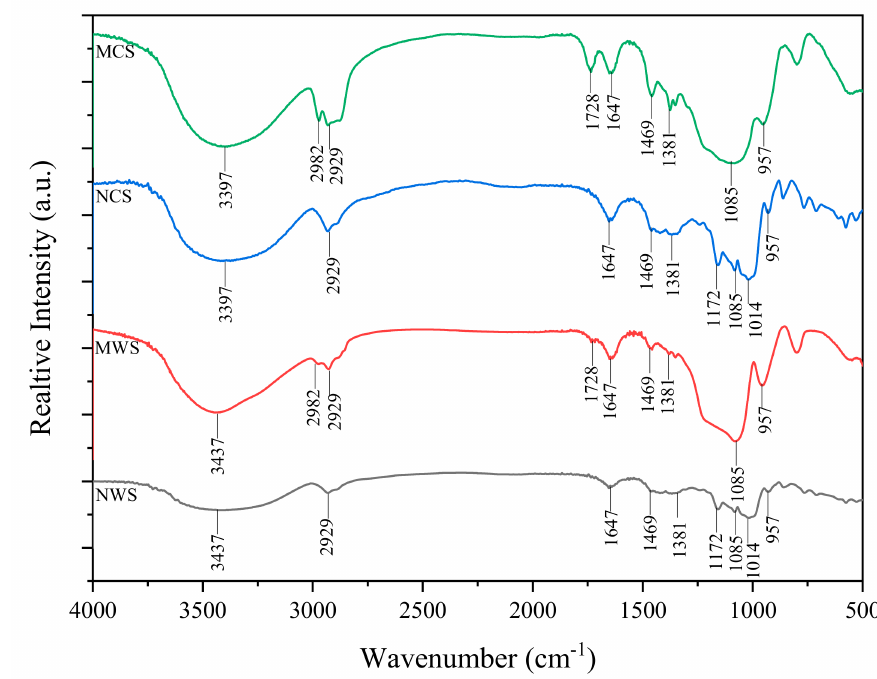
Figure 2. FTIR spectra of the native (NWS and NCS) and modified (MWS and MCS) cassava starch